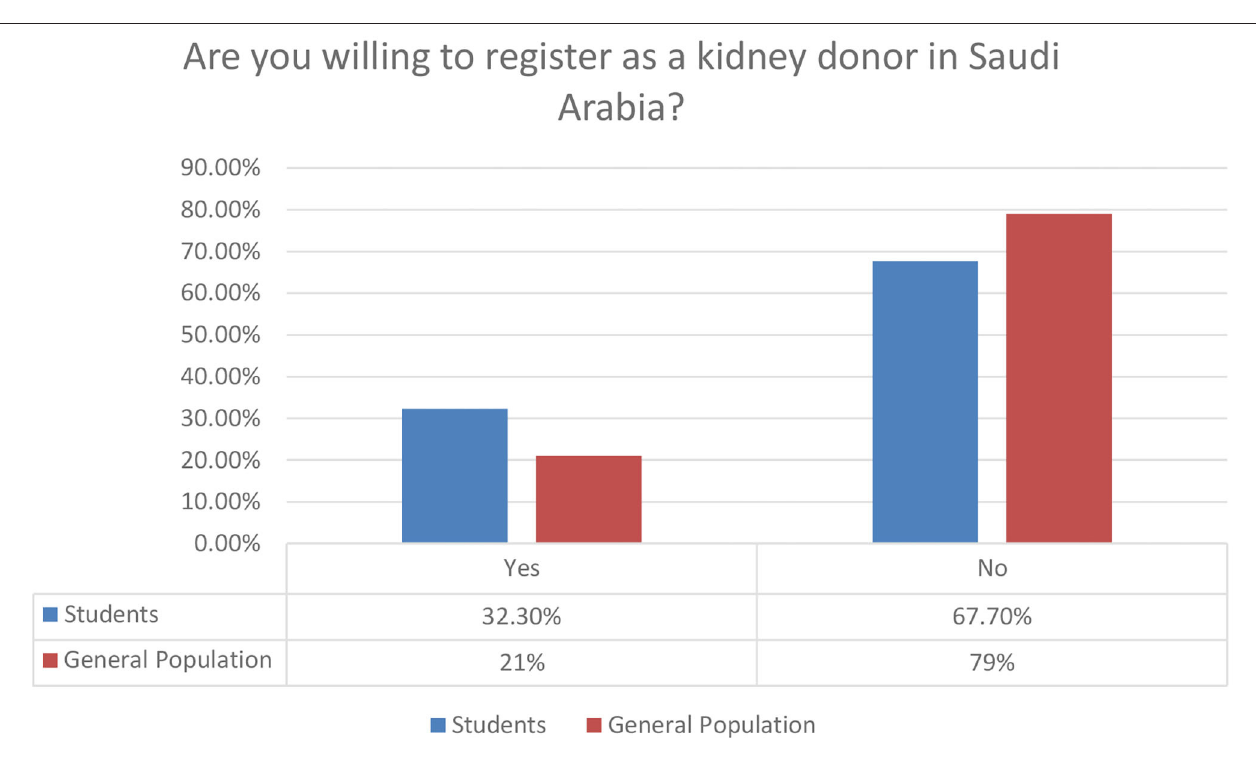
FIGURE 10 | Personal willingness to register as a kidney donor.